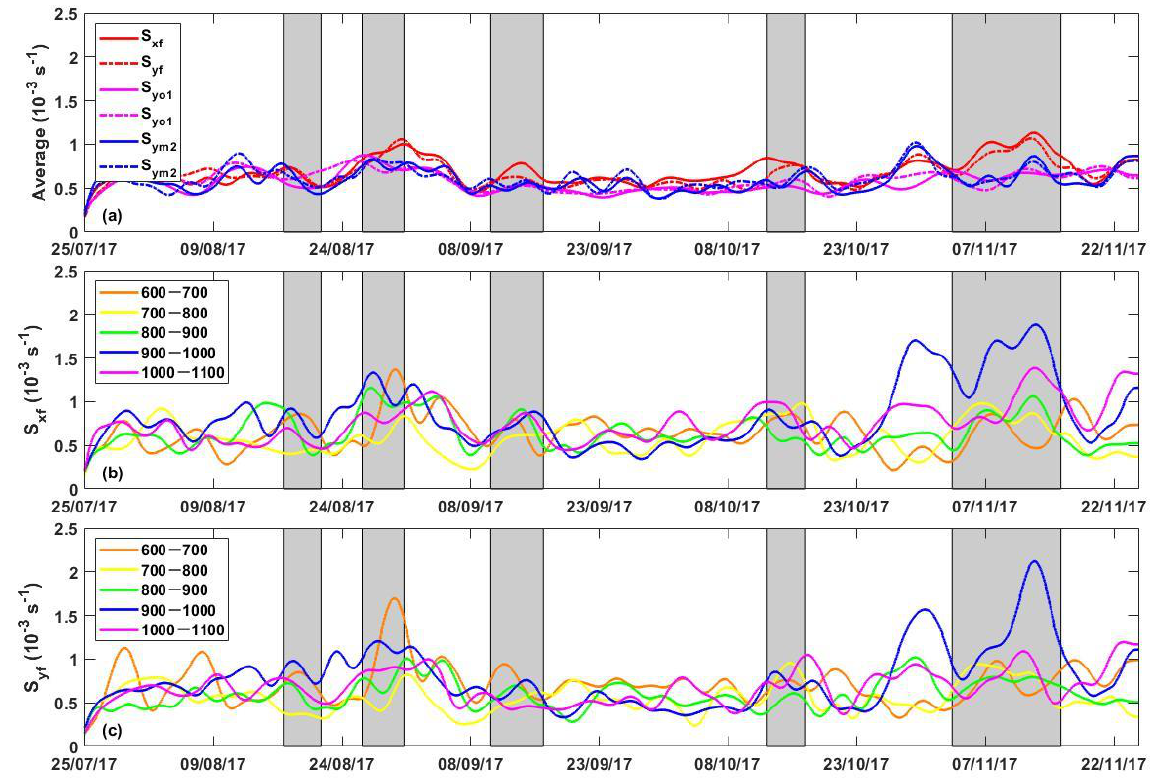
Figure 5. ( a ) The shear of NIW, diurnal and semidiurnal tides during the observation period. Red represents NIWs shear. Magenta represents diurnal tide shear. Blue represents the semidiurnal tide. The solid line represents the zonal direction. The dashed line represents the meridional direction. ( b ) Vertical shear in the zonal direction averaged every 100 m. Different colors represent different water depths, marked in the figure. ( c ) The same as ( b ), but for the meridional direction.